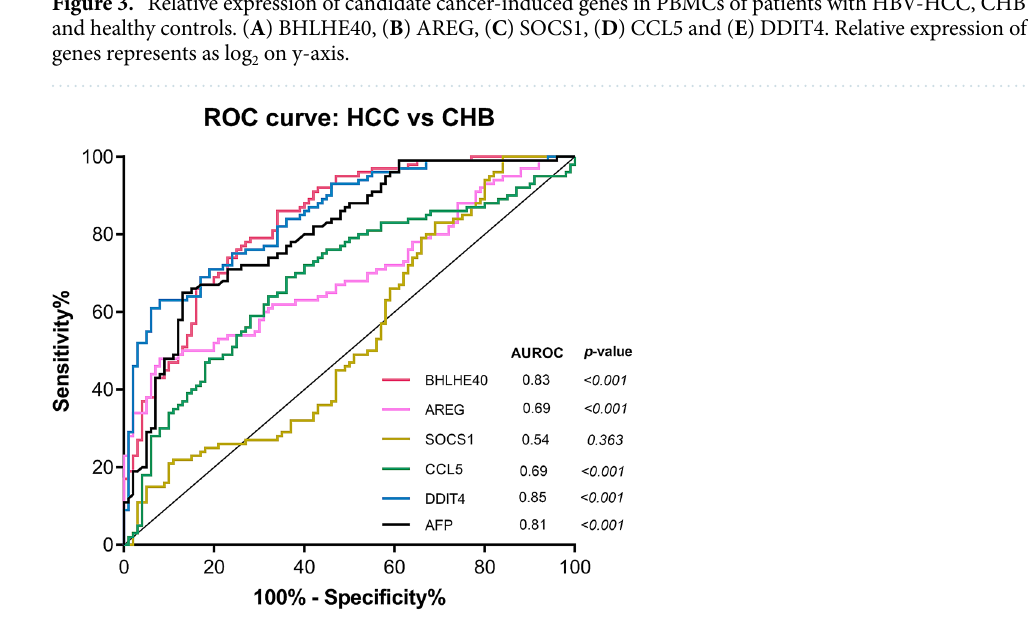
Figure 4. Receiver operating characteristic (ROC) curves of the cancer-induced genes of PBMCs in differentiating patients with HCC and